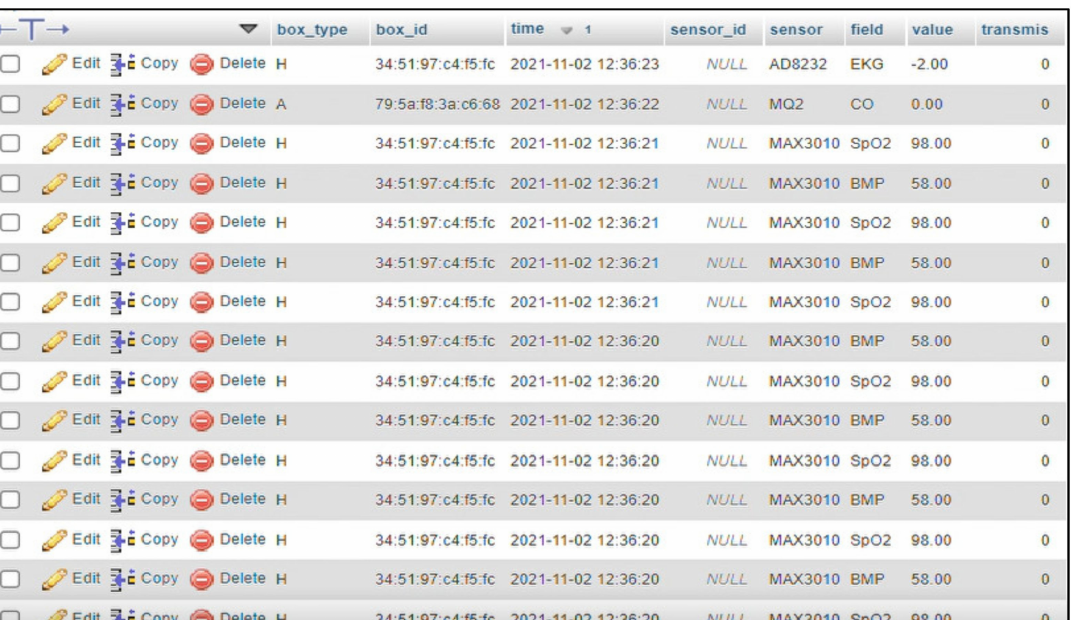
Figure 11. Illustration of recording of a series of consecutive measurements of a single parameter performed with a Withings device.